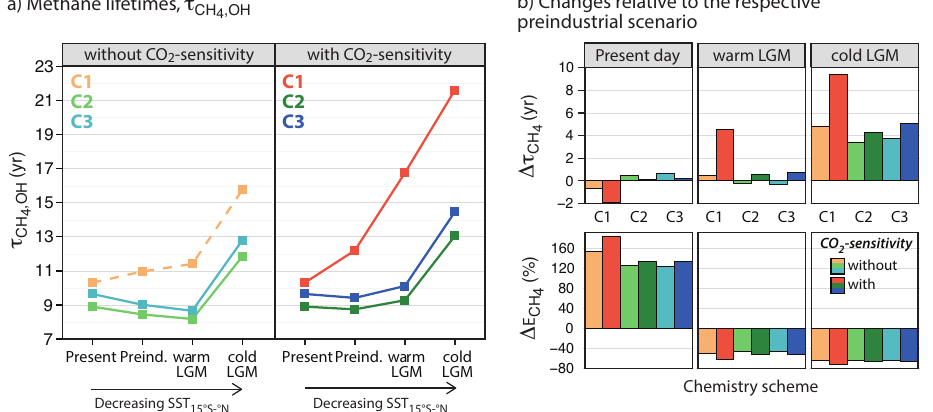
Figure 5. (a) Calculated global methane lifetime against oxidation by tropospheric OH for each combination of climate, chemistry, and plant isoprene emission scenarios. Simulations are as described in Table 2; colors are as in Fig. 2. The dotted light-orange line represents the results reported in Murray et al. (2014) for their “best estimate” lightning and fire emissions scenarios. (b) Changes in the global methane lifetimes (years) and emissions (%) relative to their respective preindustrial scenarios (e.g., C1-w present day relative to C1-w preindustrial). Colors are as in Fig. 3. Changes in methane emissions are calculated by assuming that they scale with changes in methane loss by OH in the